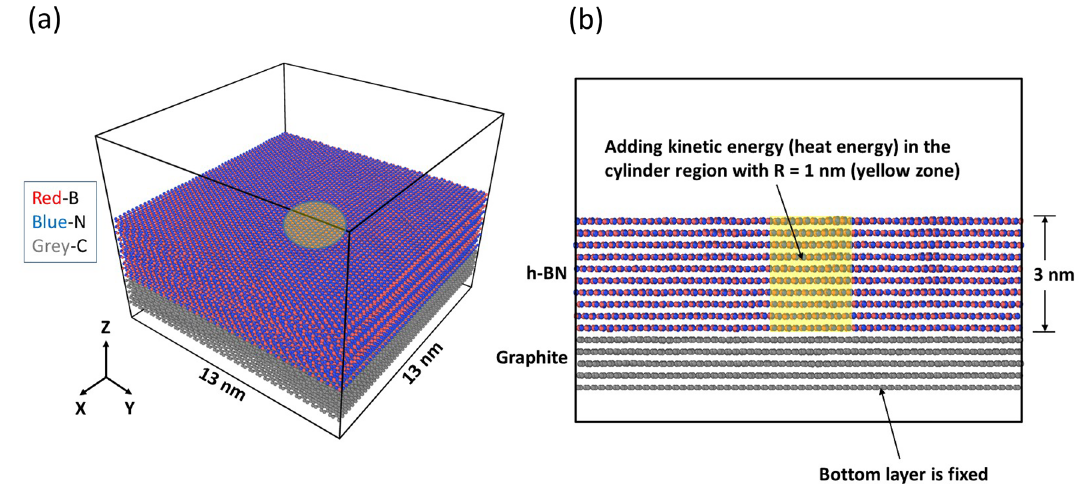
Figure 1. Schematic illustration of lattice structures and simulation model. ( a ) The 3D simulation model. ( b ) The cross-section of the simulation model. The yellow zone is the energy exchange due to the collisions between electrons and h-BN